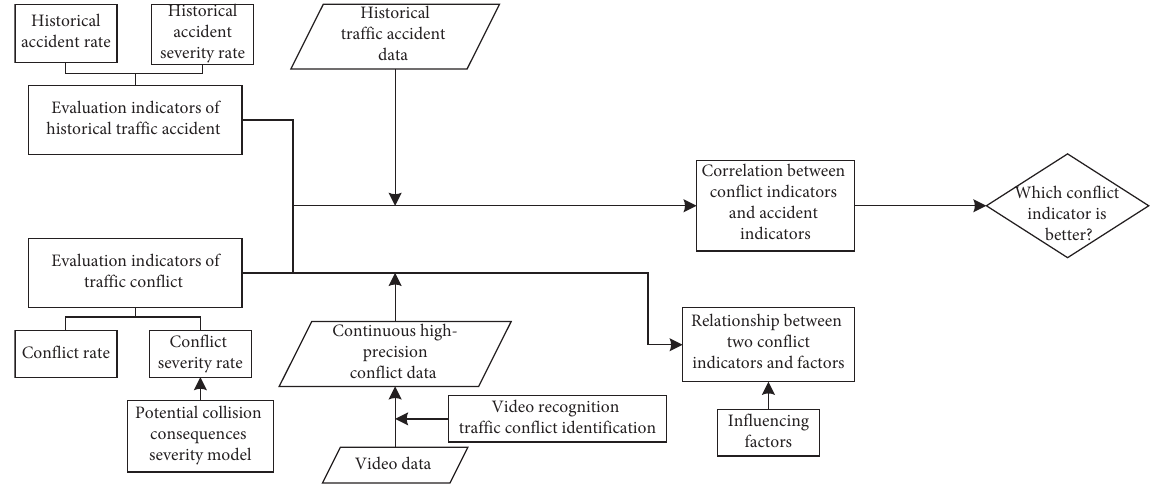
Figure 8: Analysis flow diagram. Table 5: Accident rates and accident severity rates of all sections.